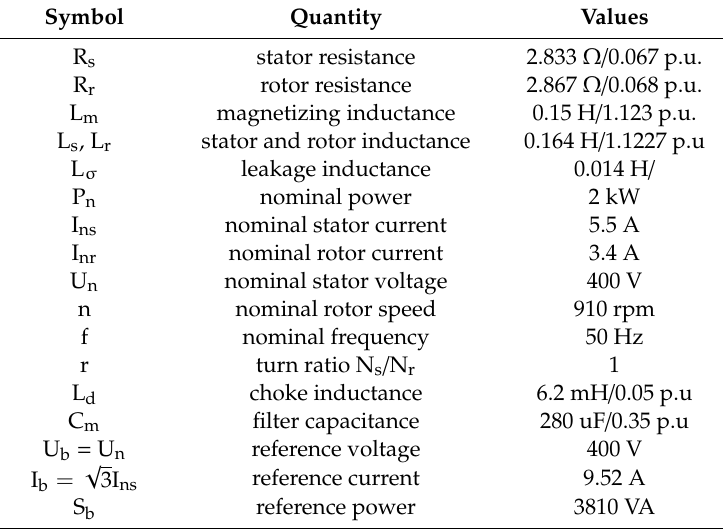
Table A1. Generator parameters and reference